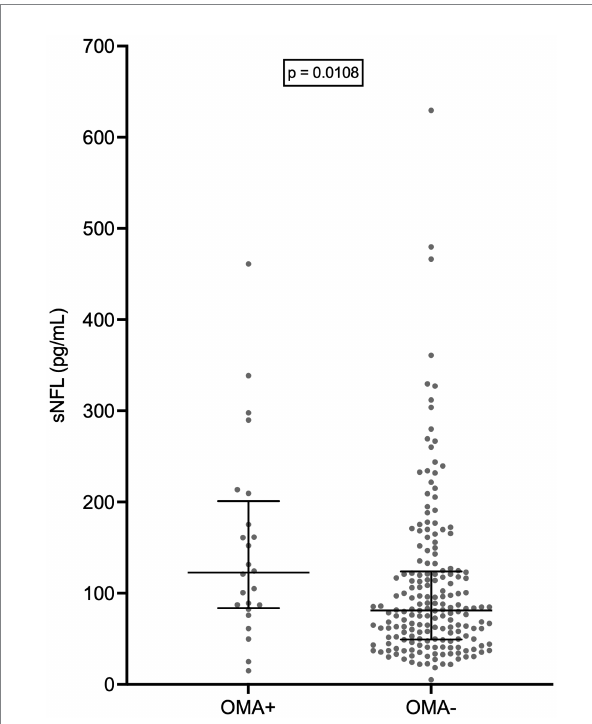
FIGURE 6 Serum NFL levels in patients with and without oculomotor abnormalities. Wide horizontal bars represent median values, narrower horizontal bars represent first and third quartiles. NFL, neurofilament light chain; OMA+, patients with oculomotor abnormalities; OMA − , patients without oculomotor abnormalities; sNFL, serum neurofilament light chain.